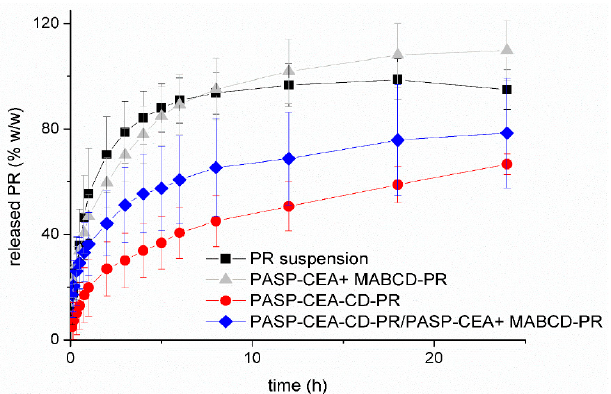
Figure 6. Drug release from the formulations containing prednisolone (PR). Cumulative mean values and standard deviations (SD) n = 3; PR: prednisolone, PASP-CEA: Thiolated poly(aspartic acid),